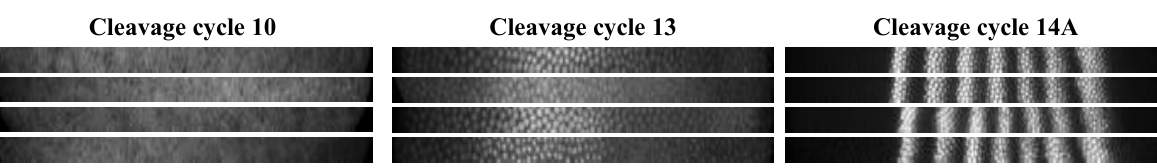
Figure 6: Visual estimation of spatiotemporal variability of gene